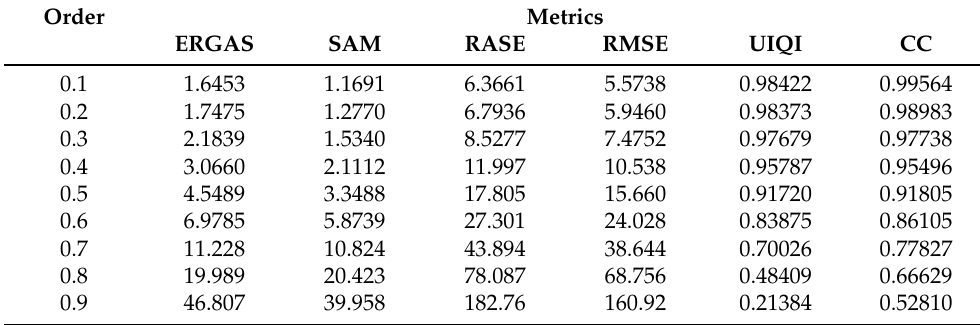
Table 2. Results of the original method of determining fractional derivatives proposed in